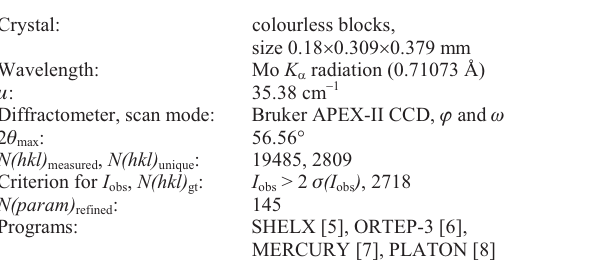
Table 1. Data collection and handling.